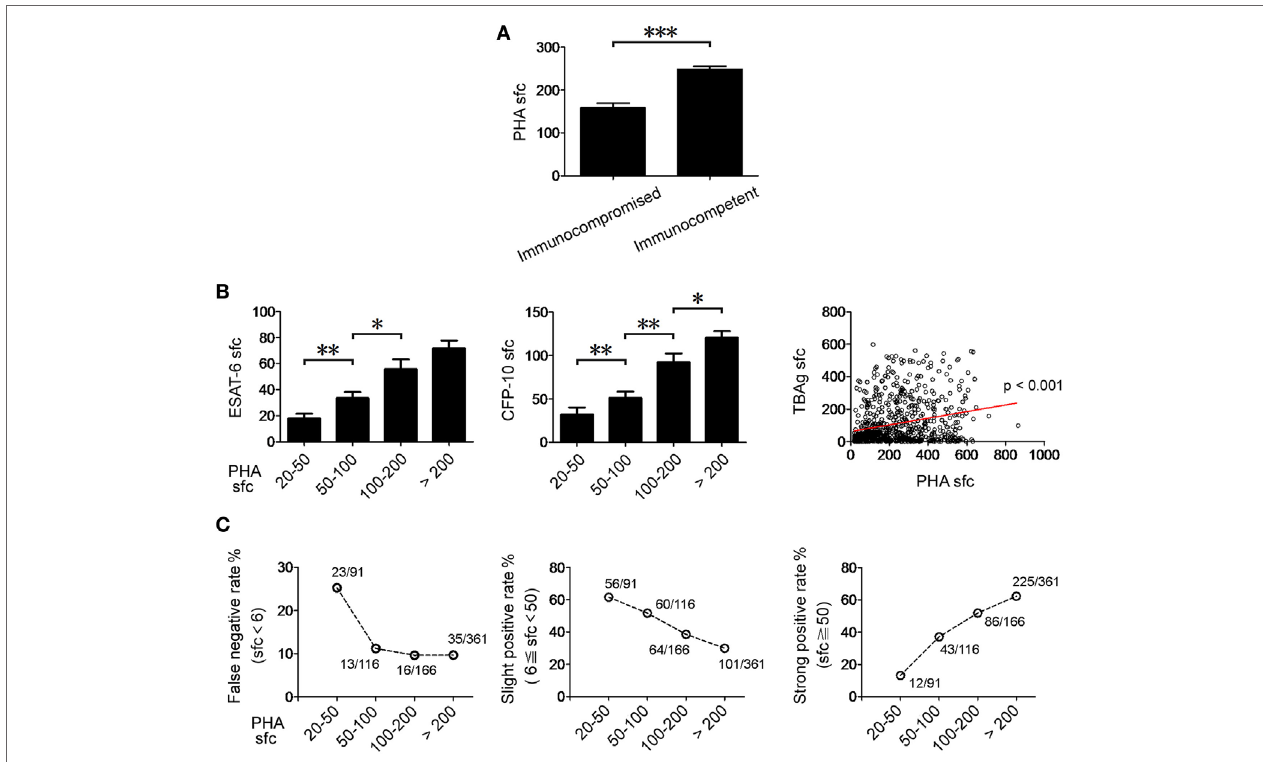
FigUre 5 | The relationship between PHA sfc and T-SPOT results in EPTB patients. (a) Histograms showing PHA sfc in immunocompetent ( n = 528) and immunocompromised ( n = 119) EPTB patients. (B) Histograms showing ESAT-6 and CFP-10 sfc in EPTB patients with different PHA categories (PHA sfc 20–50,